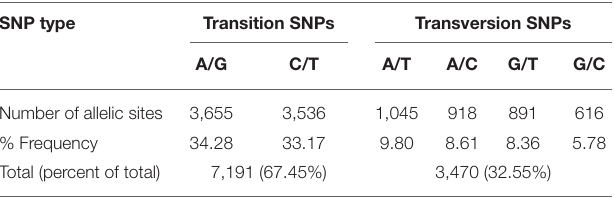
TABLE 1 | Percentage of transition and transversion single nucleotide polymorphisms (SNPs) across the Schima superba genome. SNP type